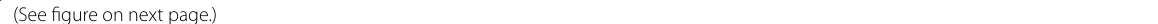
Fig. 2 MG1363-pMG36e-GLP-1 reversed the pathological changes induced by LPS. a MG1363-pMG36e-GLP-1 reduced the expression of TLR4, p-IκBαand p-p65 on mouse brain induced by LPS (IHC staining of hippocampus). b MG1363-pMG36e-GLP-1 decreased the expression of p-AKT/ AKT, p-GSK3β/GSK3βand β-catenin on mouse brain induced by LPS (IHC staining of hippocampus). c MG1363-pMG36e-GLP-1 alleviated the Aβdeposition on mouse brain induced by LPS (IF staining of hippocampus). C, control group (n MG1363-pMG36e-GLP-1 group (n